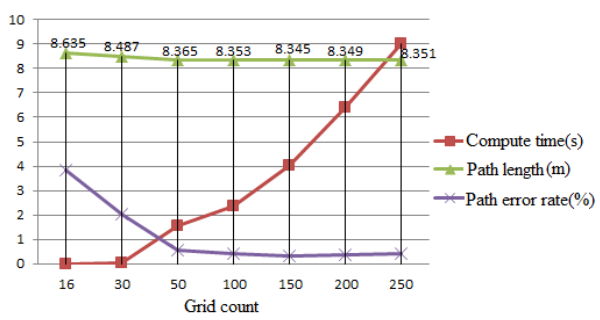
Table 1. Comparison of time and path length with different grid count and size